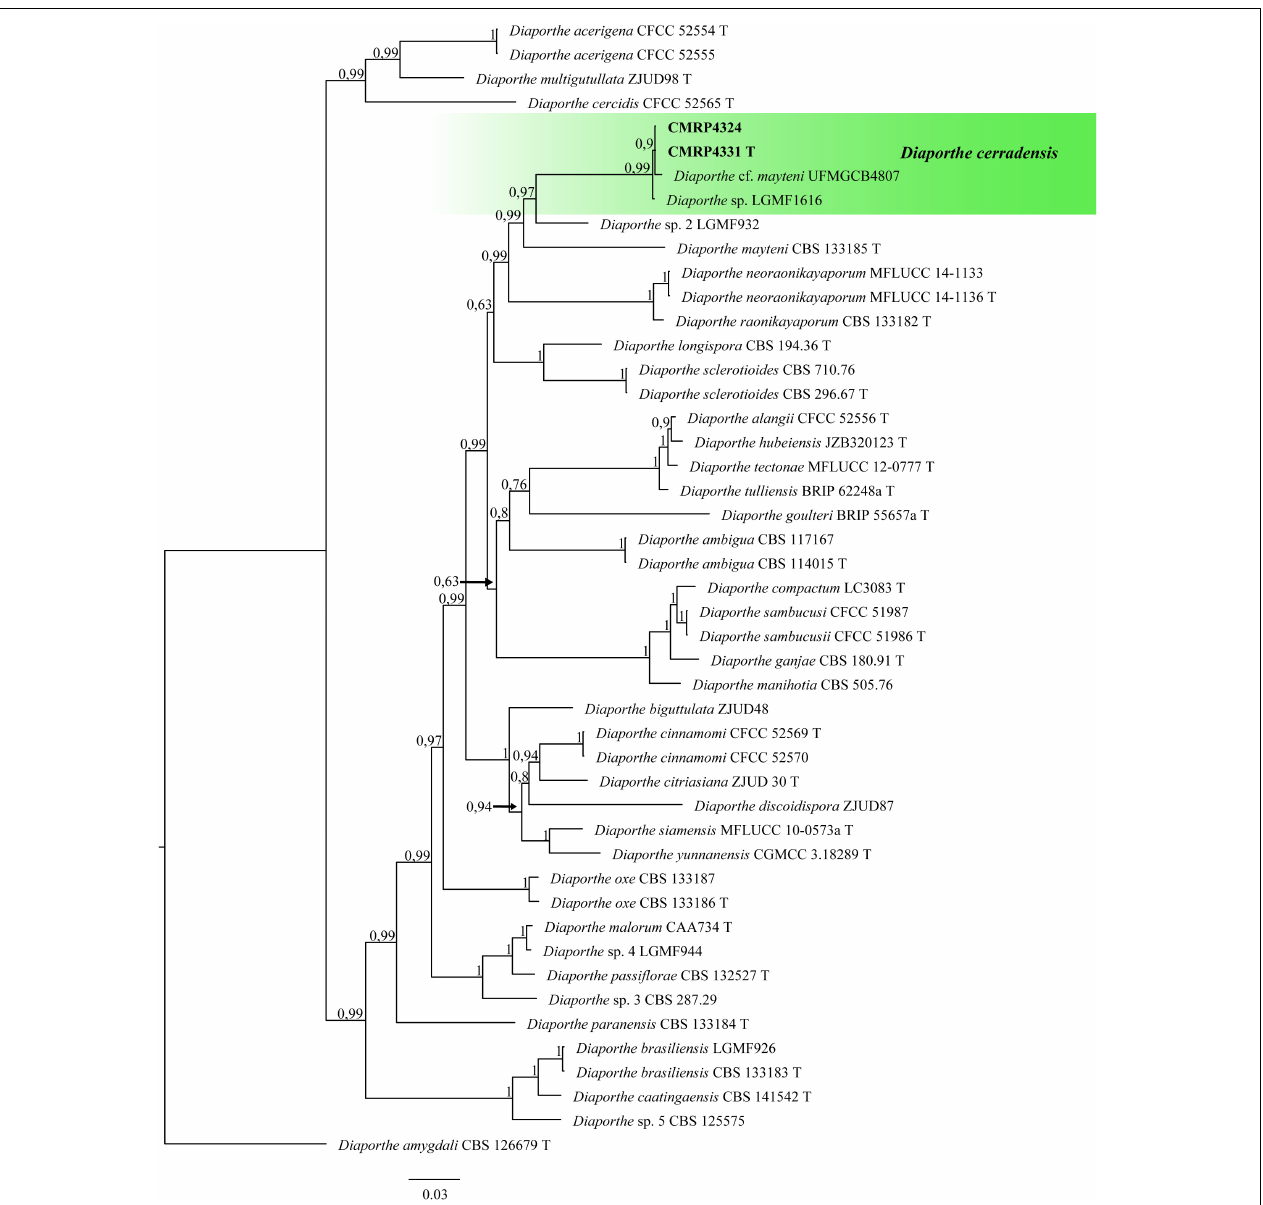
FIGURE 2 | Bayesian Inference phylogenetic tree of Diaporthe species based on multiple alignment of ITS, tub2 , tef1 , his3, and cal partial sequences. The data matrix had 47 taxa and 2,133 characters. The species Diaporthe amygdali (CBS 126679 T) was used as outgroup. Strains marked with a “ T ” correspond to type sequences. The scale bar of 0.03 represents the number of changes. The sequence of the isolates here studied is presented with its isolation code (CMRP4331 and CMRP4324) highlighted in bold.